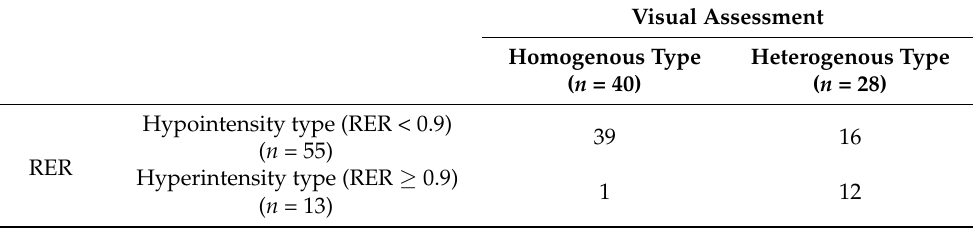
Table 4. Relationship between visual assessment and relative enhancement ratio in EOB-MRI hepato- biliary